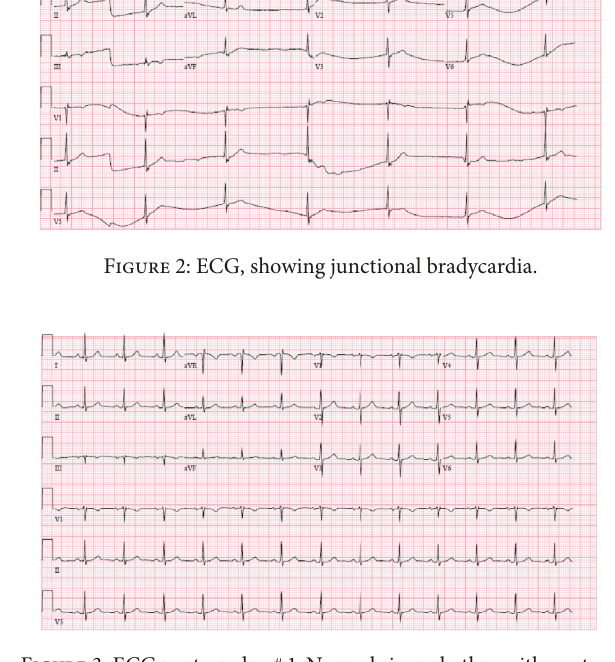
Figure 3: ECG post-op day # 1. Normal sinus rhythm with a rate of 75, and no ischemic